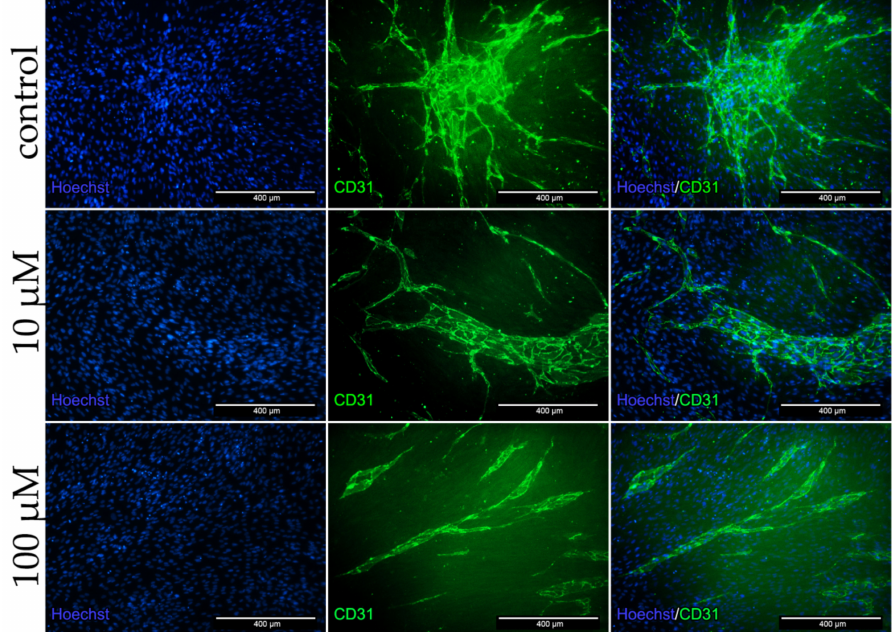
Figure 8. Immunofluorescence staining for CD31 after 96 h incubation in DM with 10 and 100 µ M dex and untreated control in the co-culture. HUVECs were stained with CD31 (green) specific antibody. Nucleus staining was performed using Hoechst dye